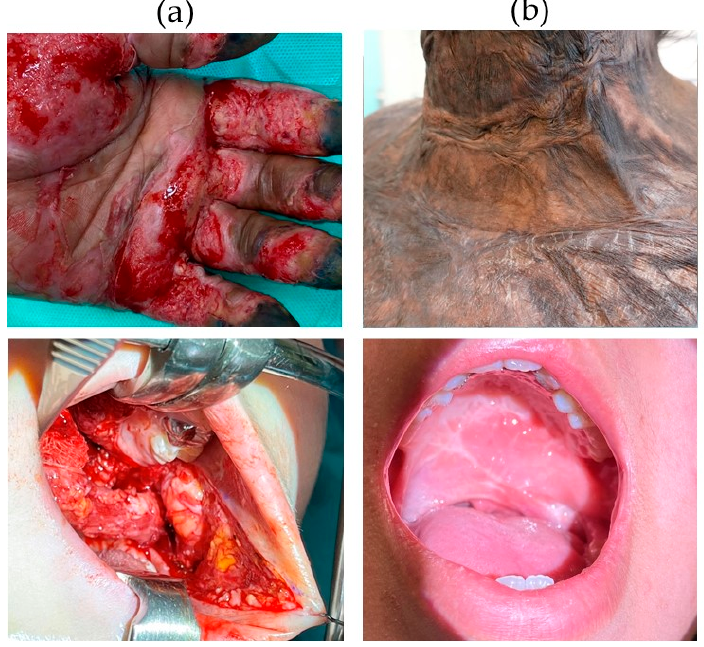
Figure 1. Comparison of human skin and oral mucosal wounds and scars. ( a ) Clinical example of a burn wound in skin (upper picture) and an oral wound from schisis corrective surgery (lower picture); ( b ) clinical example of a skin scar after burn injury ( upper picture ) and an oral scar after schisis corrective surgery ( lower picture ).